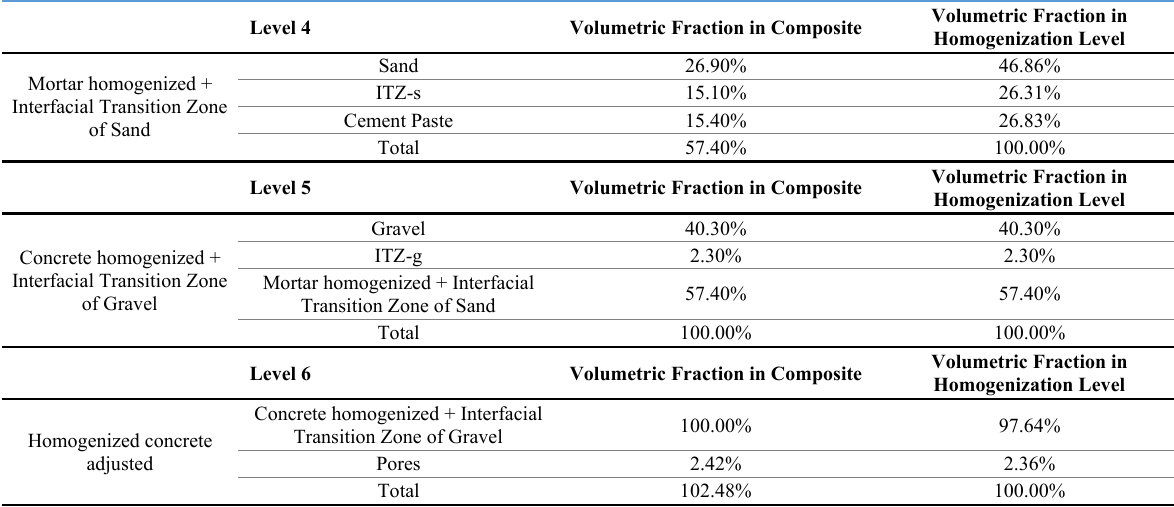
Table 7. Correction of volumetric fractions in the homogenization